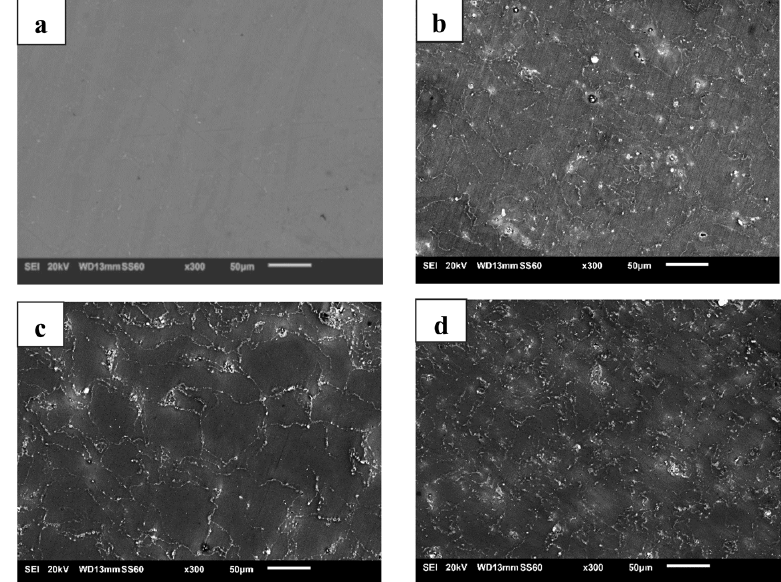
Figure 3. SEM micrographs of the: ( a ) Mg and CCA particle distribution in the ( b ) Mg-2.5CCA; ( c ) Mg-5CCA; and ( d ) Mg-7.5CCA composites.